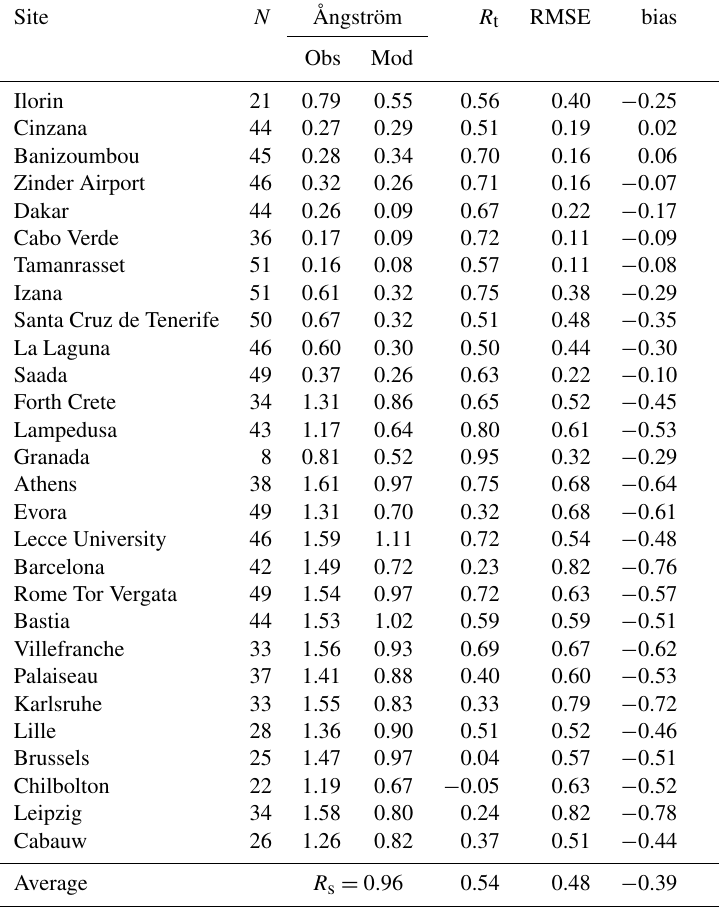
Table 6. Scores for the comparisons between observations (AERONET) and model (CHIMERE) for the Ångström exponent. Results are presented with N the number of daily mean available measurements for the period from 10 June to 30 July 2013, the temporal correlation ( R t ), the root mean square error (RMSE) and the bias (model minus observations). The last line “average” represents the spatial correlation R s between the mean observed and modeled values, and the mean averaged values of temporal correlation, RMSE and bias. Stations are sorted in increasing latitude, from south to